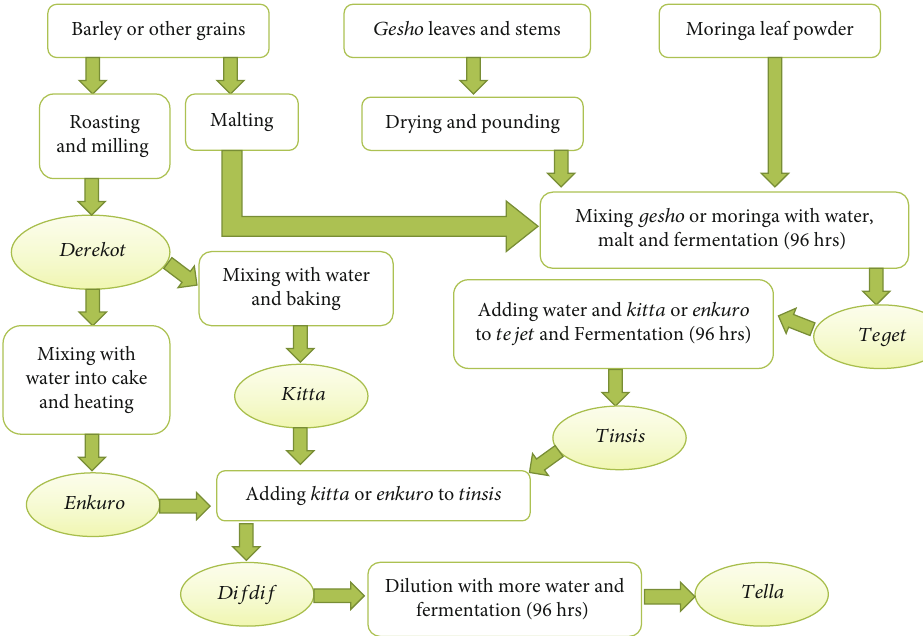
Figure 1: Flow diagram for tella making depicting the major ingredients and operations.